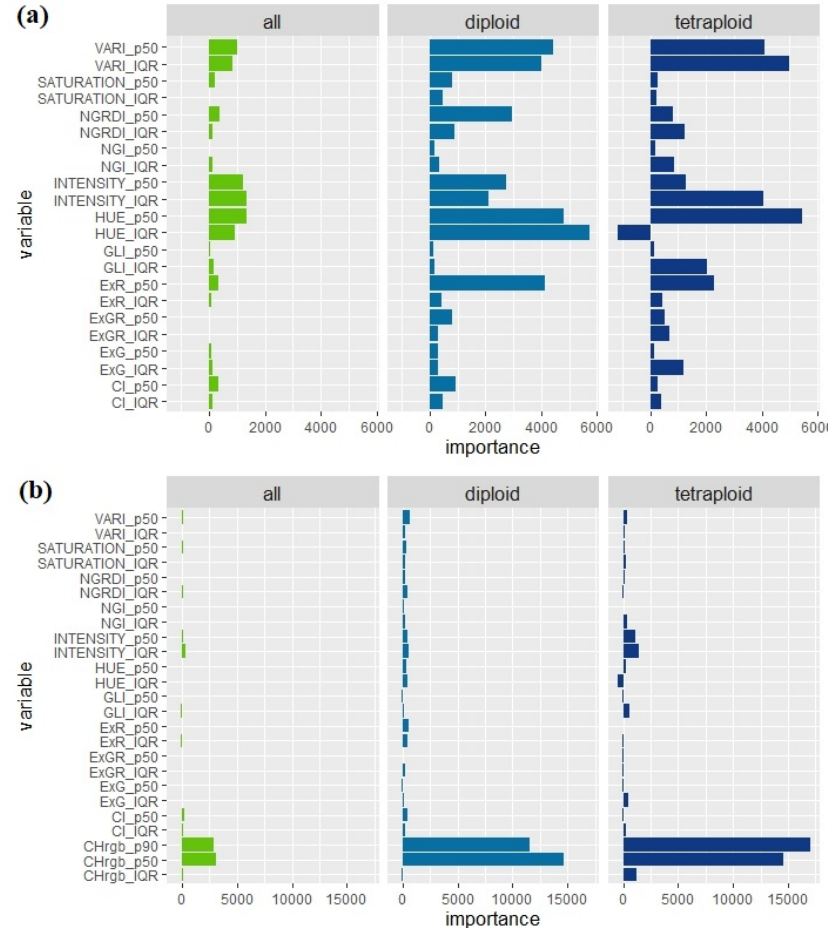
Figure 8. Random forest variable importance plot showing predictor variables based on RGB sensor: ( a ) VIs, ( b ) VIs combined with CH information relevant in predicting dry matter yield of perennial ryegrass for all, diploid, and tetraploid tested plots.